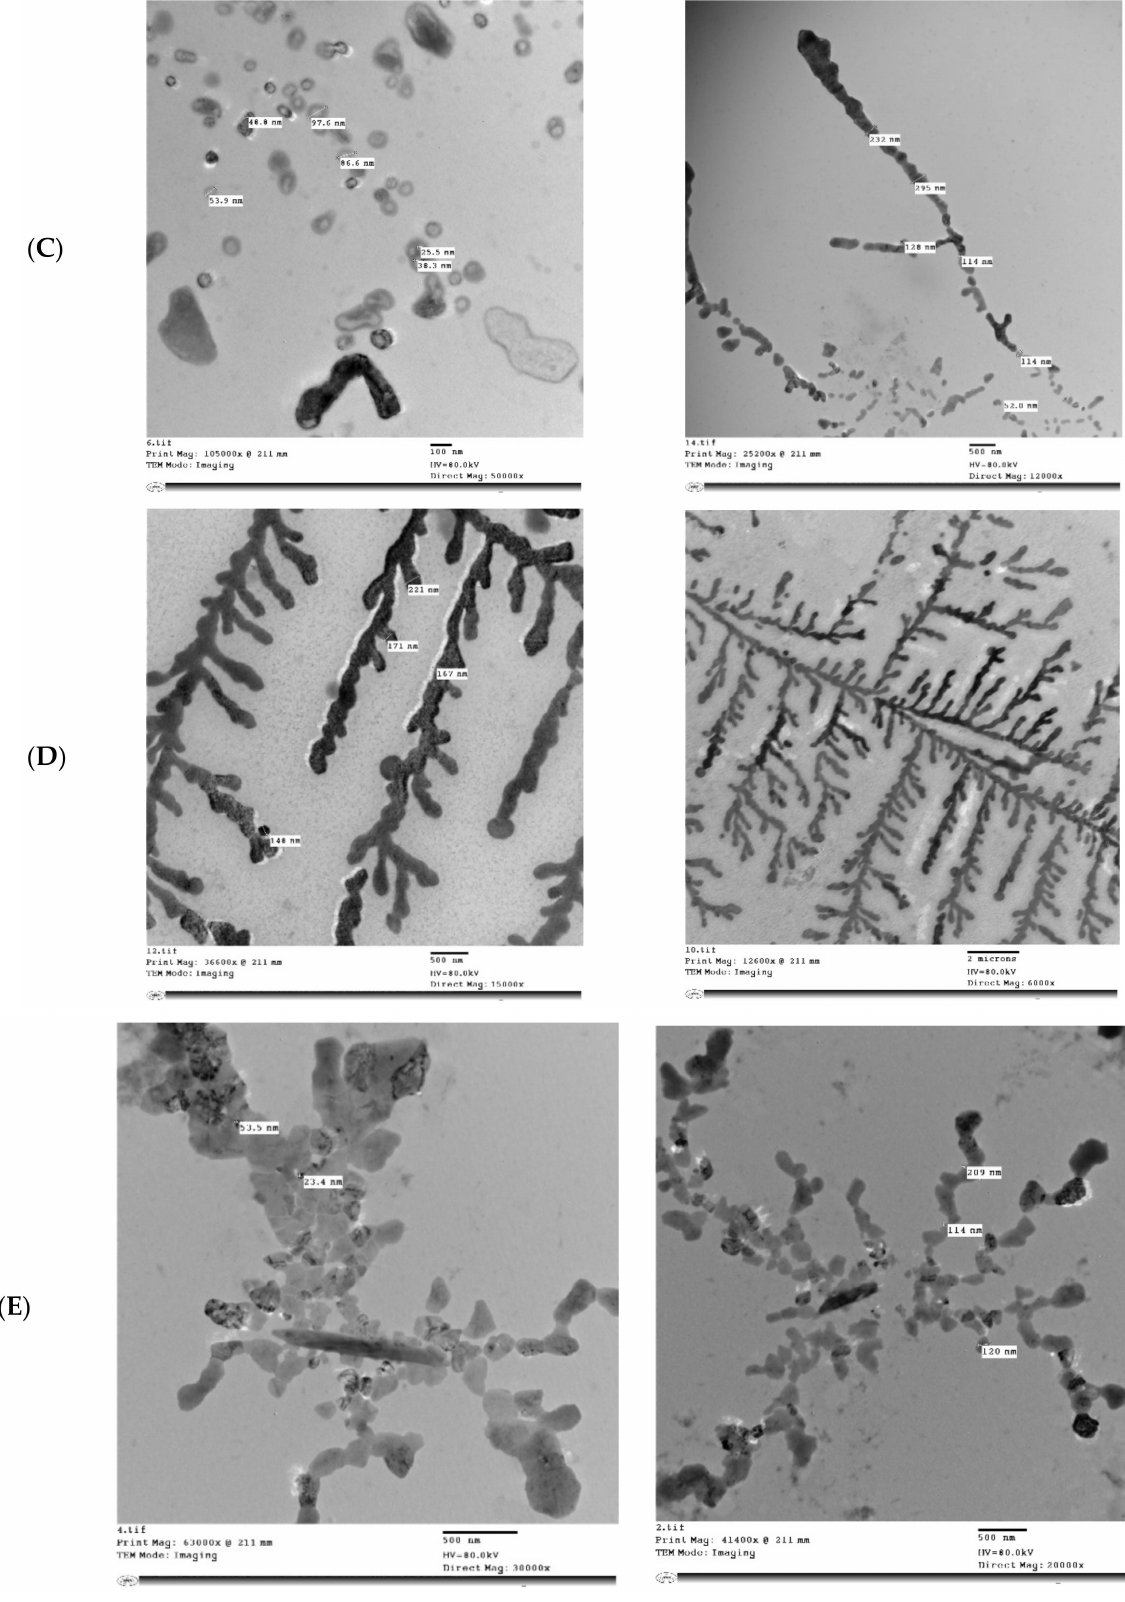
Figure 5. Transmission electron microscopy of ( A ) MP; ( B ) IHM; ( C ) NabM; ( D ) MP/IHM; and ( E ) MP/NabM. MP: milk proteins concentrate; MP/NabM: milk proteins/Nabeq mucilage complex; MP/IHM: milk proteins/Isabgol husk mucilage